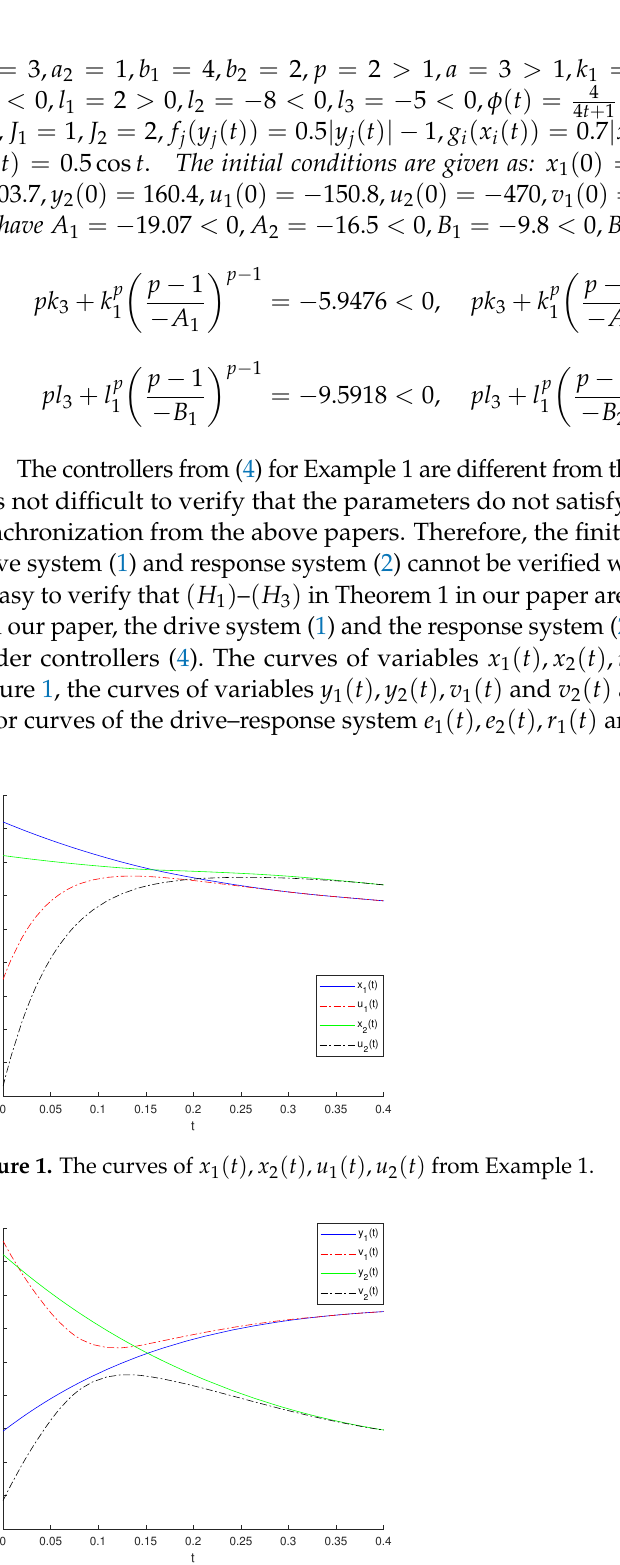
Figure 2. The curves of y 1 ( t ) , y 2 ( t ) , v 1 ( t ) , v 2 ( t ) from Example